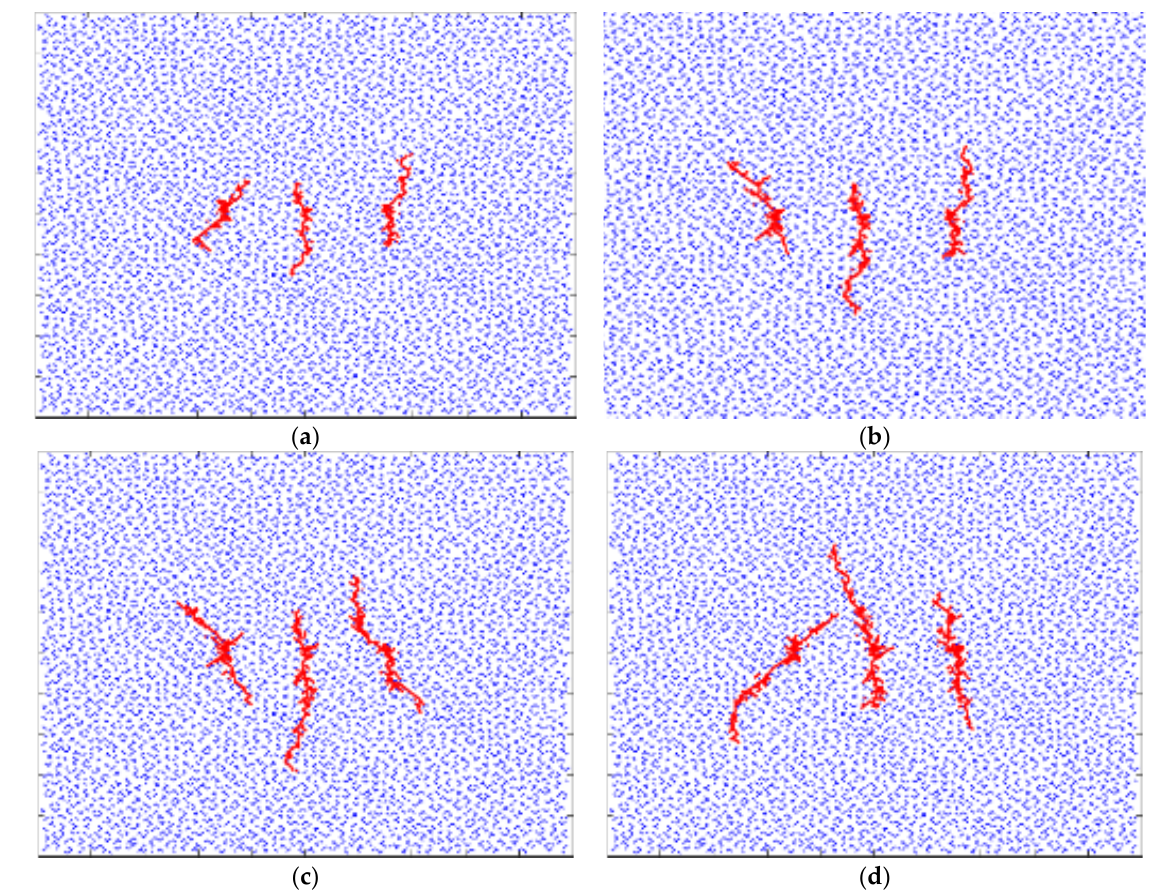
Figure 14. Fracture configuration distribution law during staged hydraulic fracture propagation in CBM reservoirs under various fracturing fluid pumping rates. ( a ) 0.18 m 3 ·min −1 , ( b ) 0.24 m 3 ·min −1 , CBM reservoirs under various fracturing fluid pumping rates. ( a ) 0.18 m 3 · min − 1 , ( b ) 0.24 m 3 · min − 1 , ( c ) 0.3 m 3 ·min −1 , ( d ) 0.36 m 3 ·min −1 . ( c ) 0.3 m 3 · min − 1 , ( d ) 0.36 m 3 · min − 1